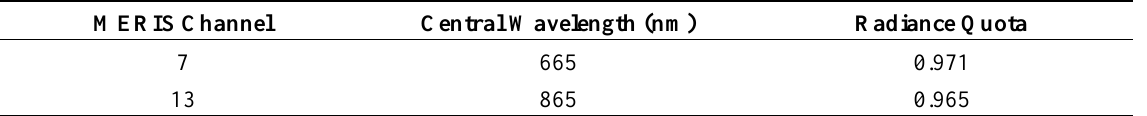
Table 10. Radiance quotas for MERIS with respect to MODIS (MERIS/MODIS) deduced from SNO inter-comparisons in the period